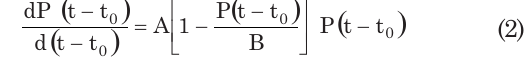
1:1000 (NBTPT:urea), as indicated by the manufacturer, one day before beginning the study. Urea was surface applied at amounts of 0.07, 0.14 and 0.21 mg/bottle, equivalent to 50, 100 and 150 kg ha -1 of N, respectively.